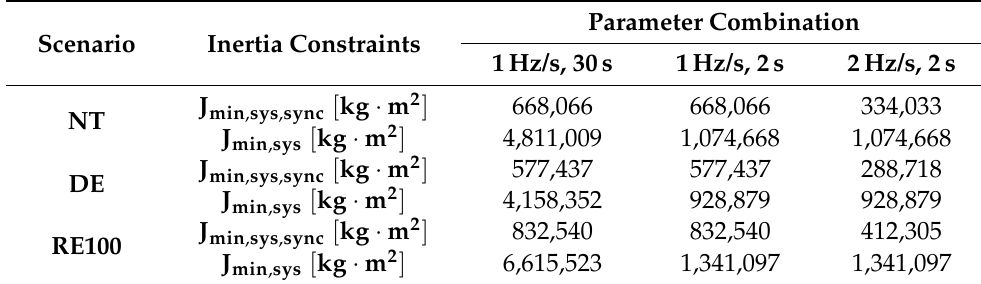
Table 6. Overview of the required system synchronous inertia and overall system inertia for Germany per scenario and parameter